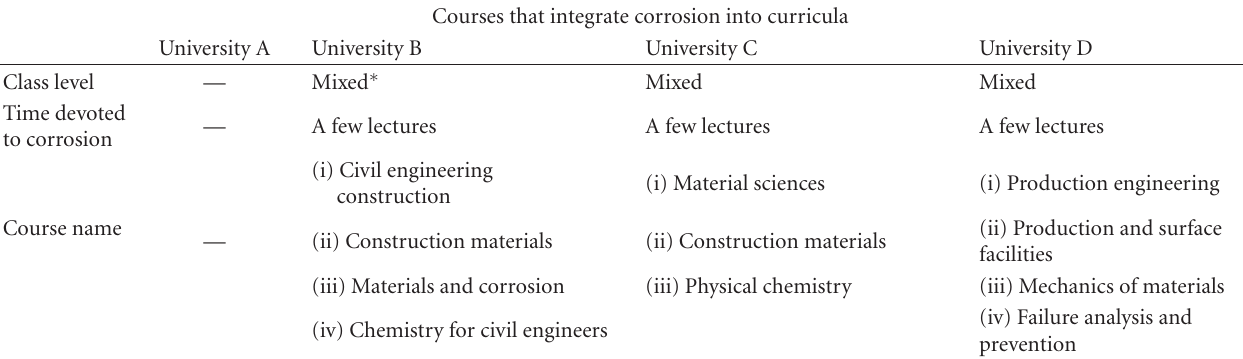
∗ Mixed: undergraduate and graduate levels.